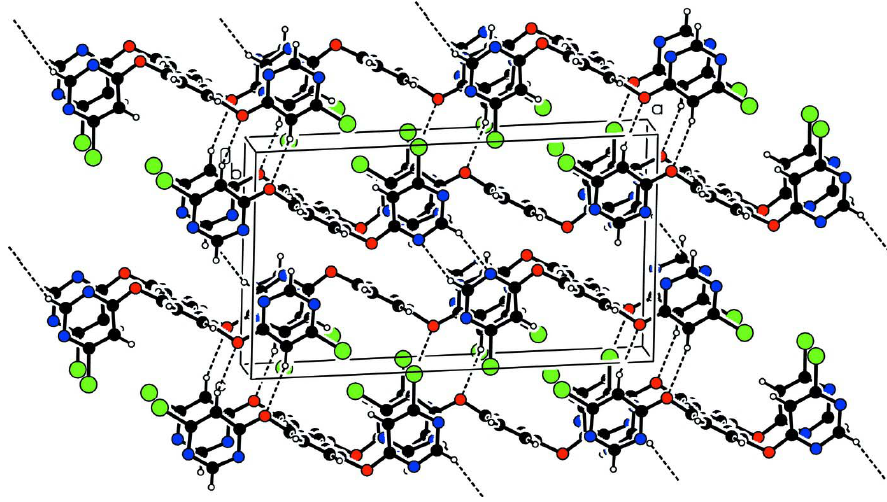
Figure 2 Part of the crystal structure with hydrogen bonds shown by dashed lines. 1,4-Bis(6-chloropyrimidin-4-yloxy)benzene Crystal